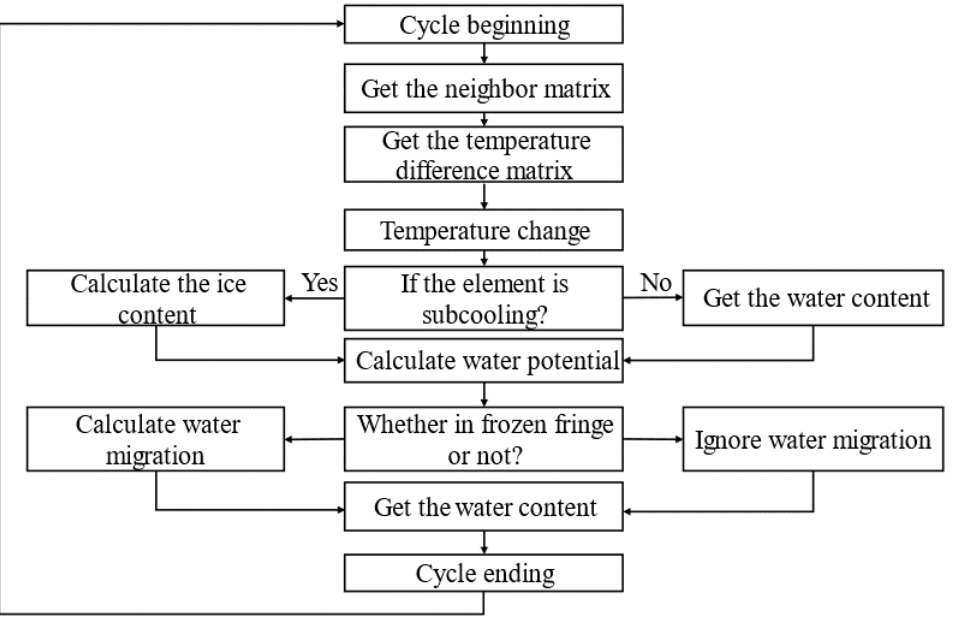
Figure 5. Numerical simulation flowchart.